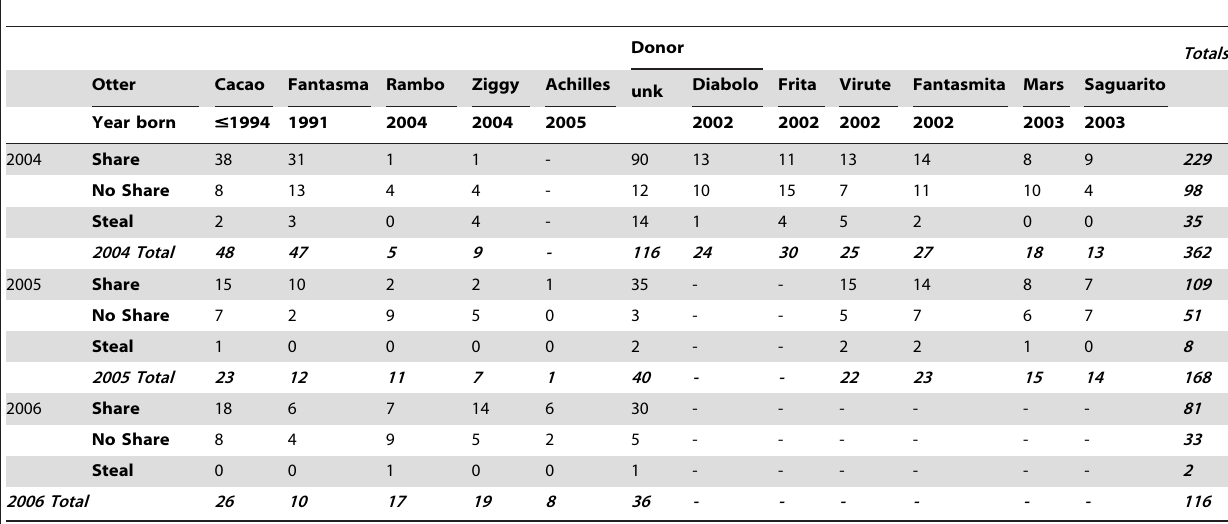
Table 1. Outcomes of all begging bouts between potential donors and beggars by year and potential donor.